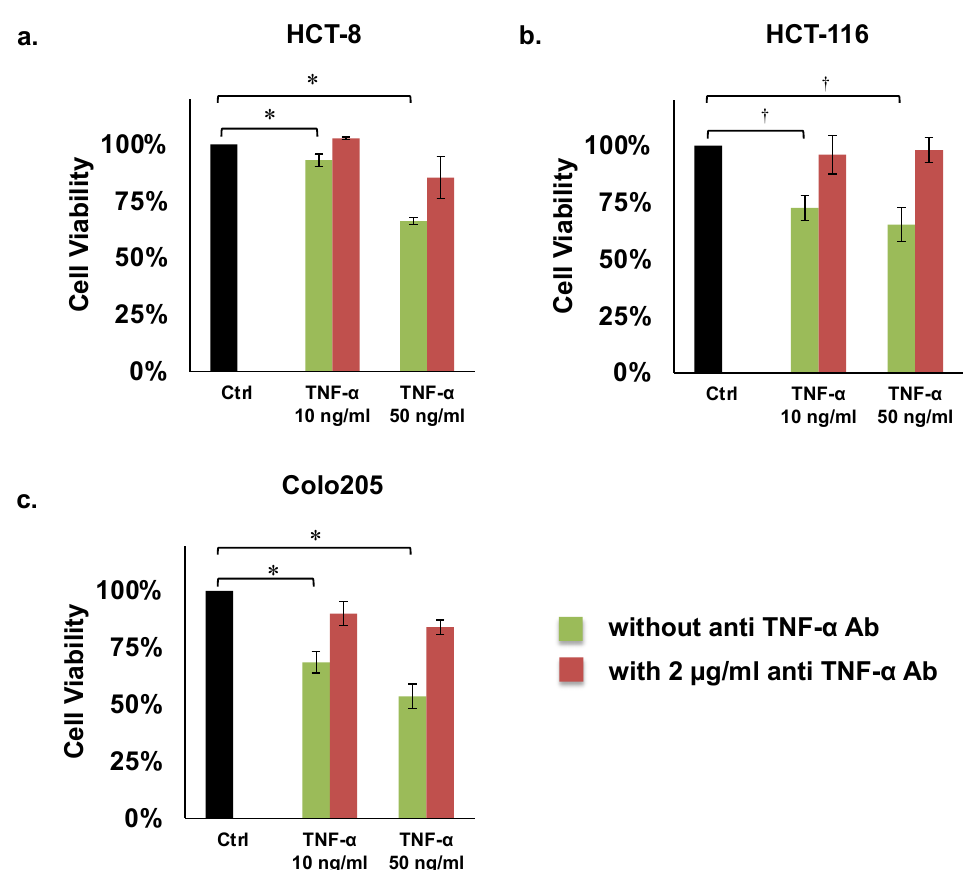
Figure 2. Proliferation assays of colon cancer cells. ( a ) HCT8, ( b ) HCT116, ( c ) COLO205. Concen- trations of TNF- α : 10 or 50 ng/mL. Concentration of human anti TNF- α Ab: 2 µ g/mL. * p < 0.01, † p < 0.05. Table 1. Summary of proliferation, migration, and invasion assays of colon cancer cell lines incu- bated with TNF-α and anti TNF-α Ab.